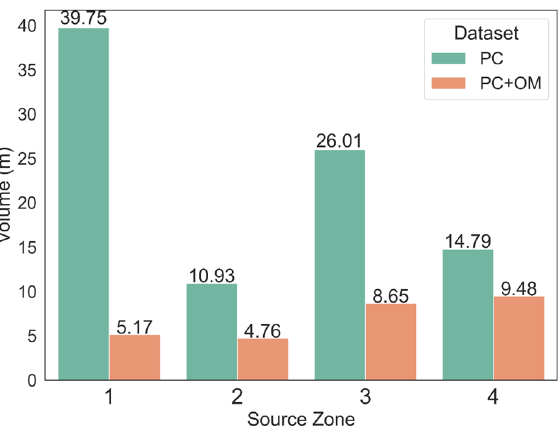
Figure 11. Mean block volume estimation by source sector and dataset.